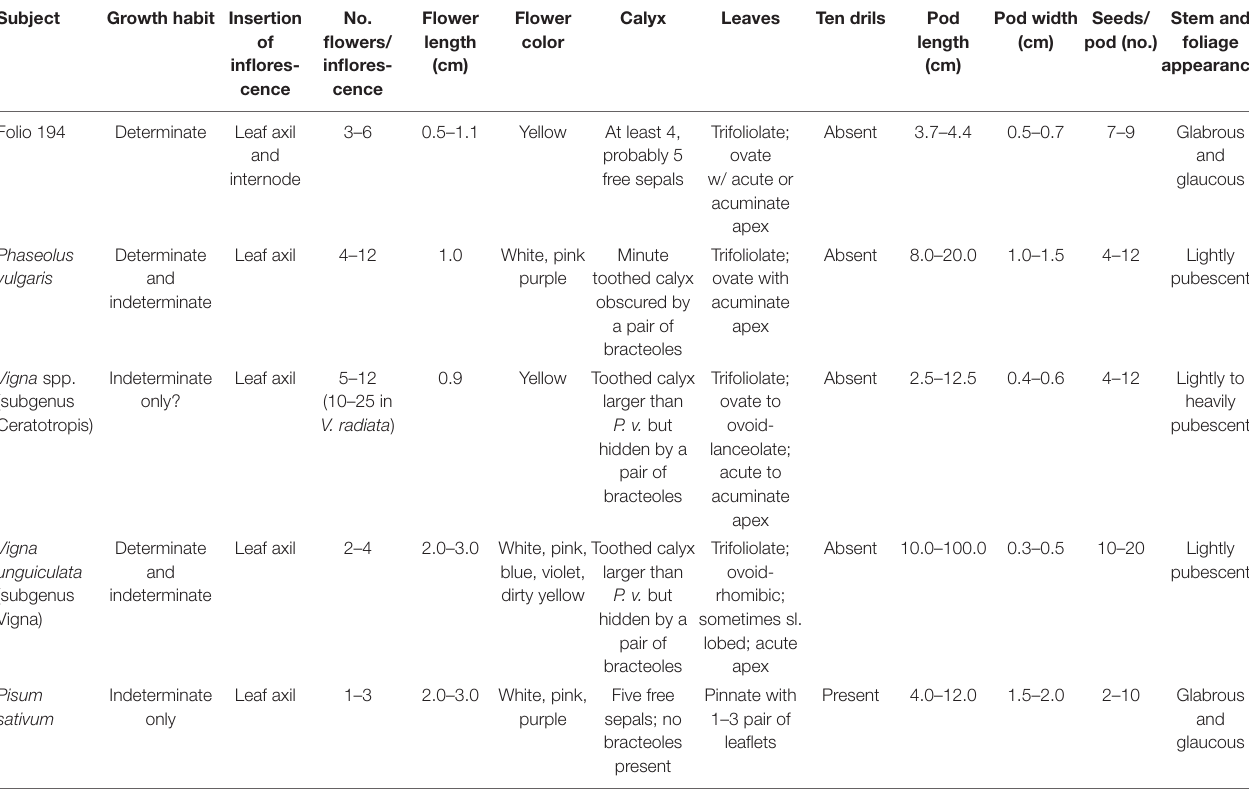
TABLE 2 | A comparison of the plant depicted in Folio 194 of the Grandes Heures d’Anne de Bretagne with several large-seeded legume